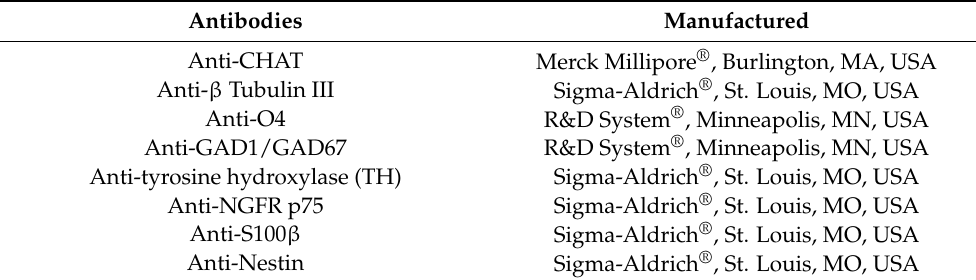
Table 2. Antibodies for